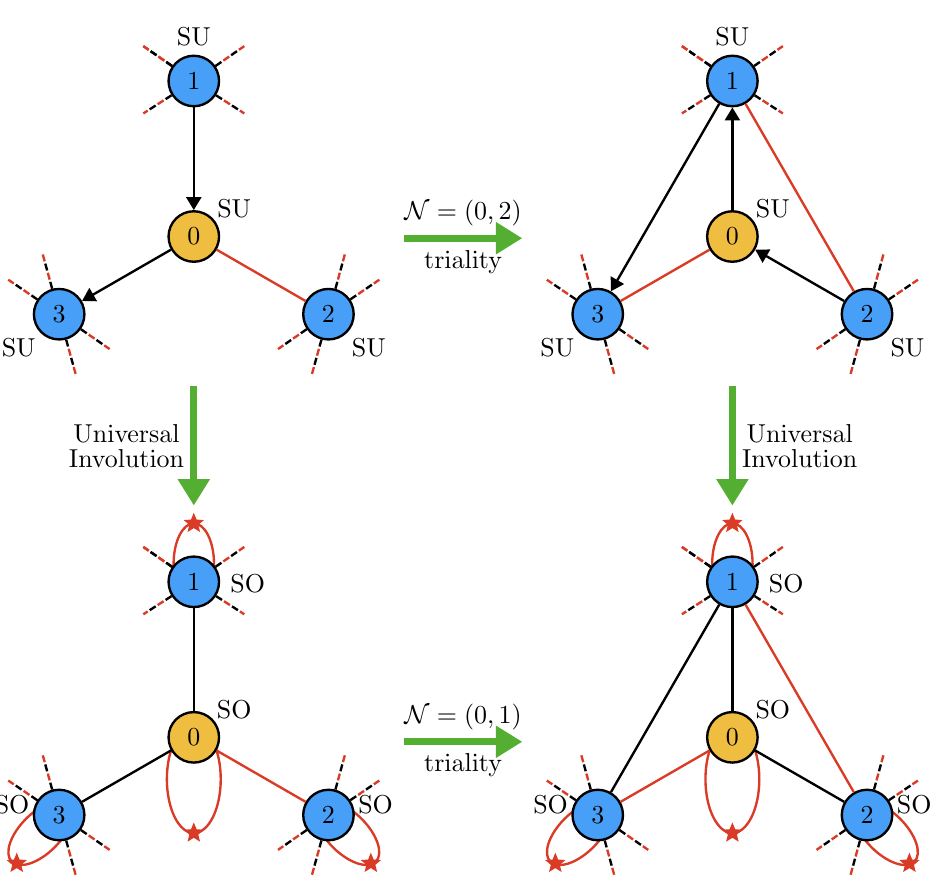
Figure 6 . The universal involution on N = (0 , 2) triality results in N = (0 , 1) triality.